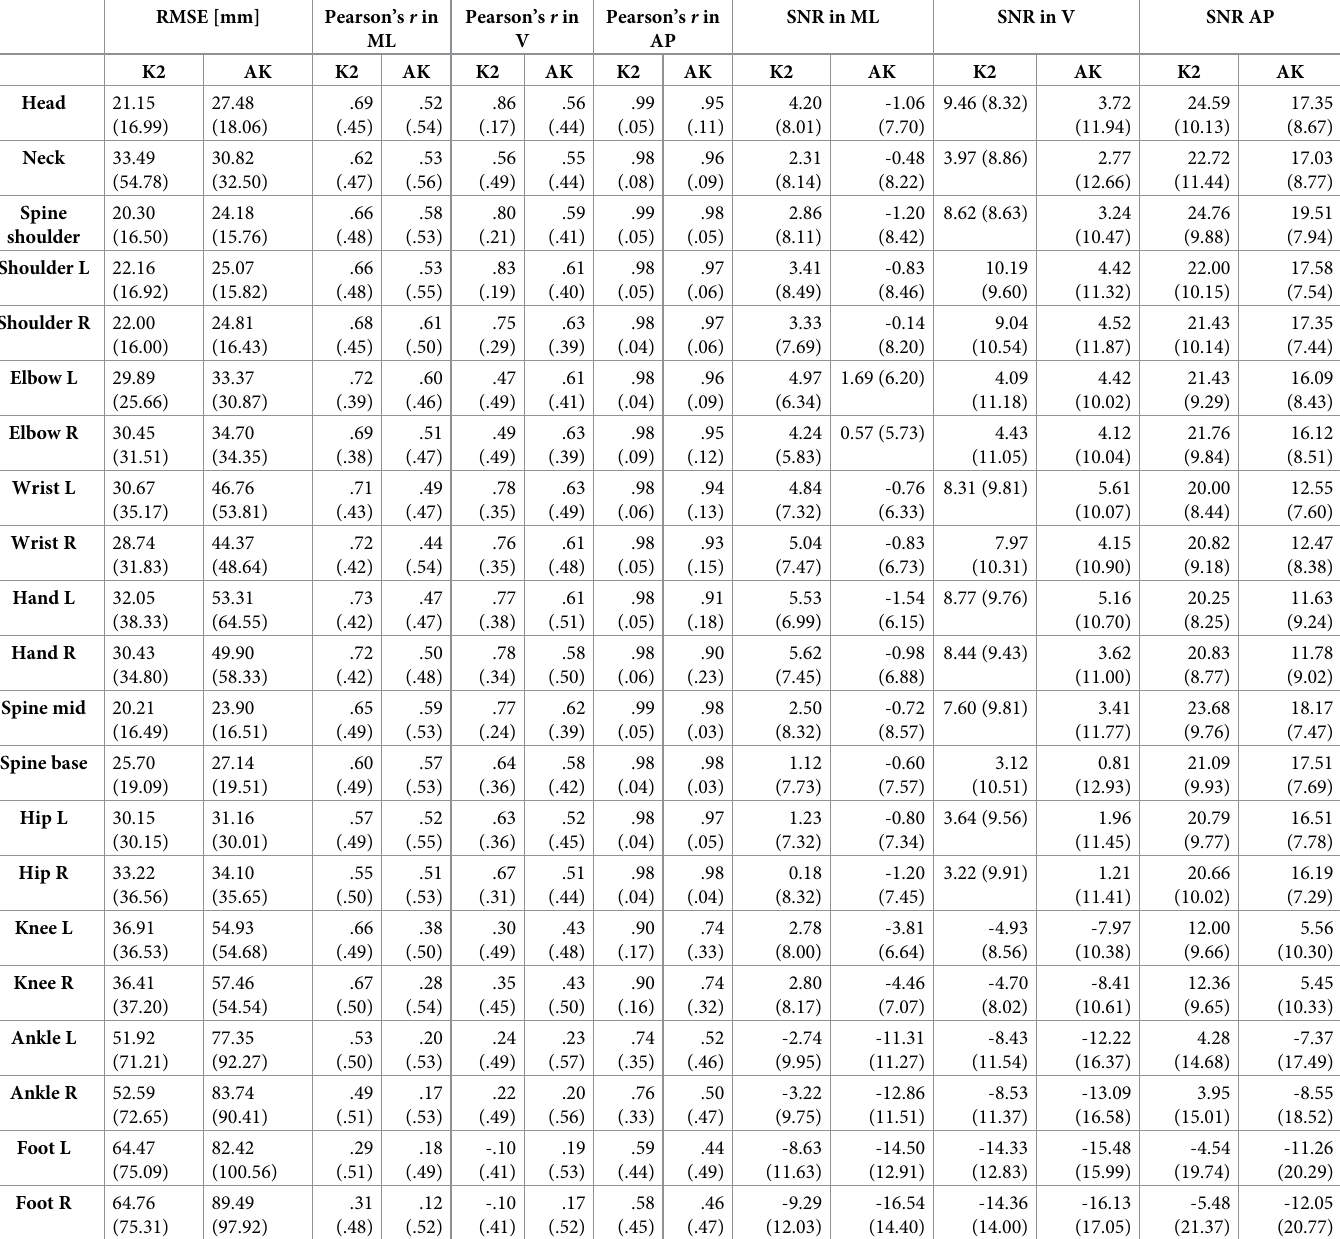
Table 3. Signal accuracies for all anatomical landmarks as mean (standard deviation) of all motor tasks, participants, and